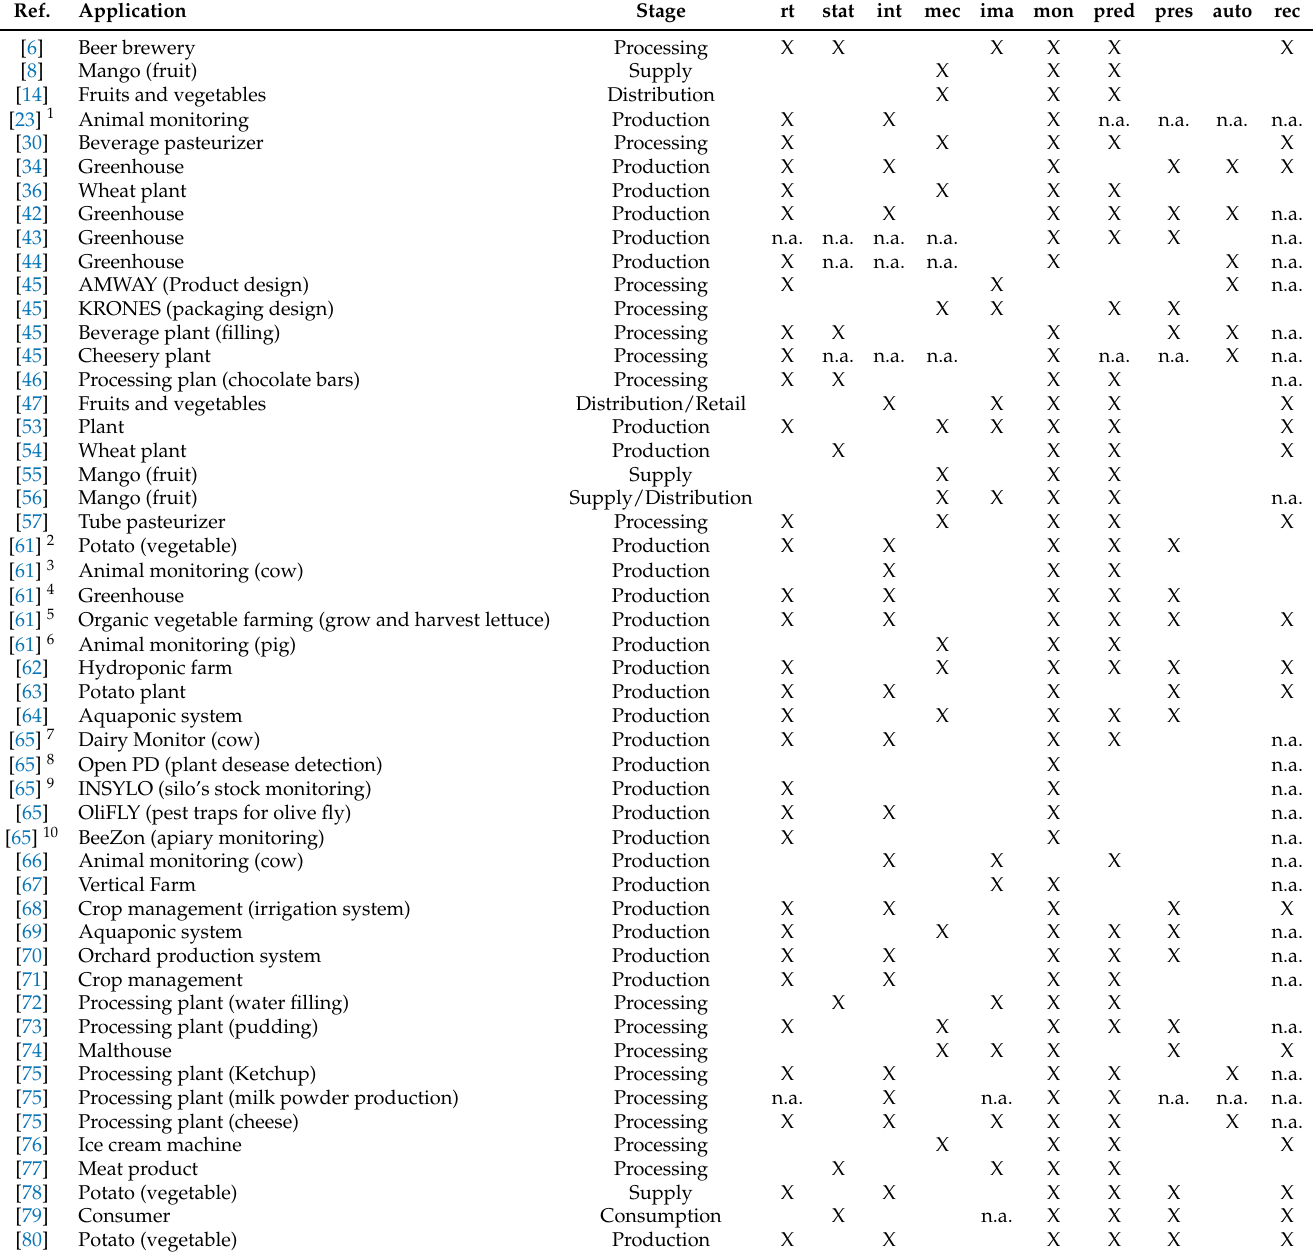
Table A1. Overview of the applications found in the literature and included into this work and their classification according to the taxonomy in Section 4.1. Please note: ‘X’ marks true, ‘n.a.’ that the information was not available. Further, the following abbreviations are used in the table header: Ref.–Reference; rt–real-time; stat–statistical; int–intelligent; mec–mechanistic;